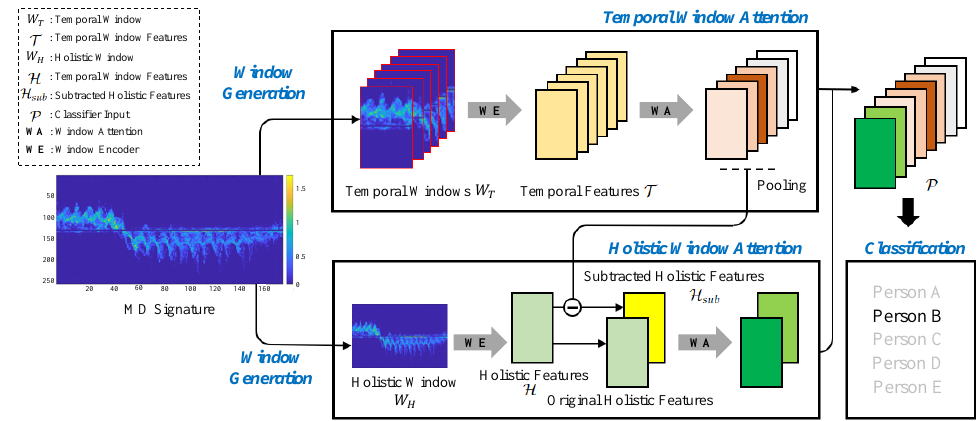
Figure 3. Illustration of Dual-Scale Doppler Attention (DSDA) for human identification. DSDA is composed of the following components: (1) Window Generation for designing temporal window and holistic window, (2) Temporal Window Attention for observing fast-moving features of arms and legs, (3) Holistic Window Attention for recognizing slow-moving features of the torso, and (4) Classification for classifying final